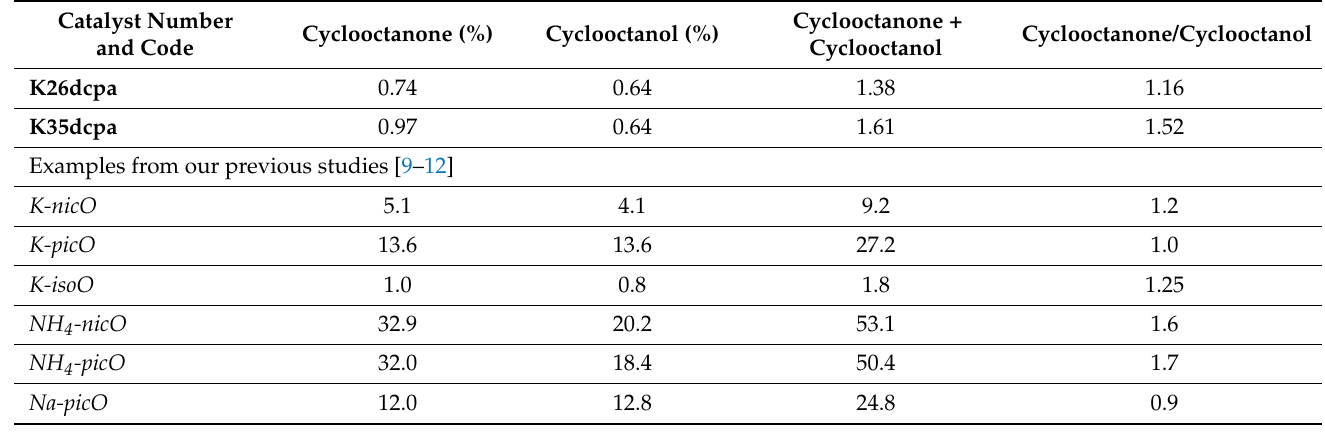
Table 6. Oxidation of cyclooctane using molybdenum complexes.